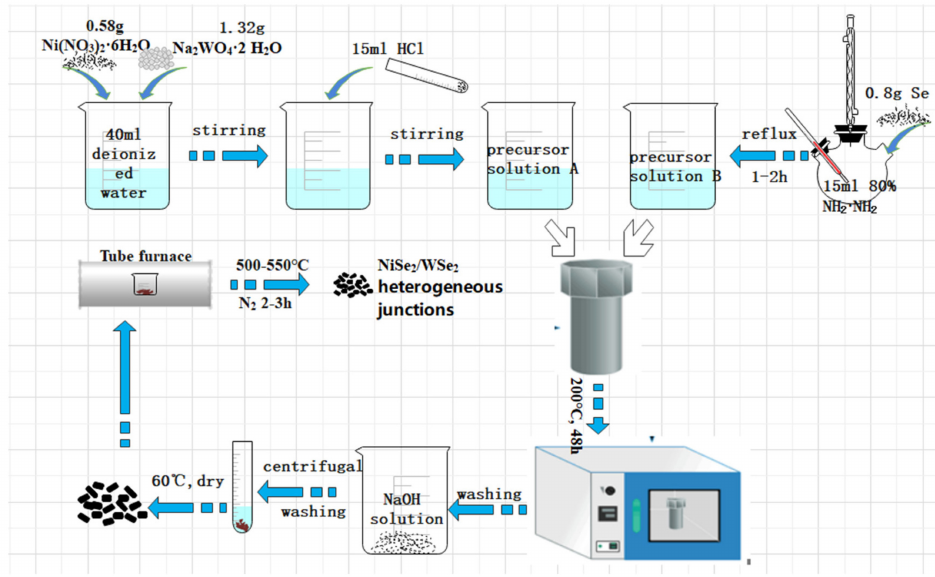
Figure 1. Block diagram of the preparation process of NiSe 2 / WSe 2